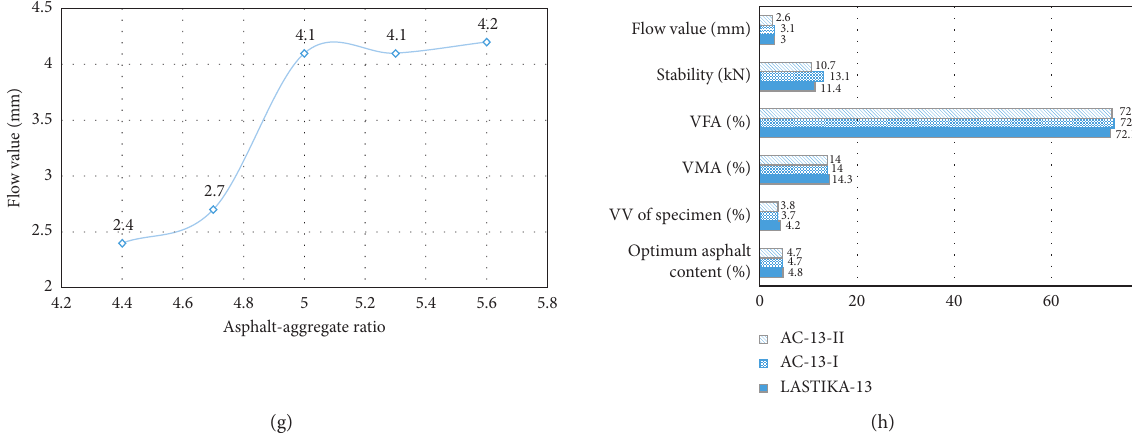
Figure 3: The determination steps of optimum asphalt content or optimum asphalt-aggregate ratio and volumetric parameters of Three asphalt mixtures during the mixture preparation. (a) Bulk density of trial NRA modified asphalt mixtures with the gradation LASTIKA-13. (b) Voids in the mineral aggregate (VMA) of trial NRA modified asphalt mixtures with the gradation LASTIKA-13. (c) Voids filled with asphalt (VFA) of trial NRA modified asphalt mixtures with the gradation LASTIKA-13. (d) Maximum theoretical density of trial NRA modified asphalt mixtures with the gradation LASTIKA-13. (e) Volume of air voids of trial NRA modified asphalt mixtures with the gradation LASTIKA-13. (f) Marshall stability of trial NRA modified asphalt mixtures with the gradation LASTIKA-13. (g) Flow value of trial NRA modified asphalt mixtures with the gradation LASTIKA-13. (h) Summary of trial asphalt mixtures: AC-13-I, AC-13-II, and